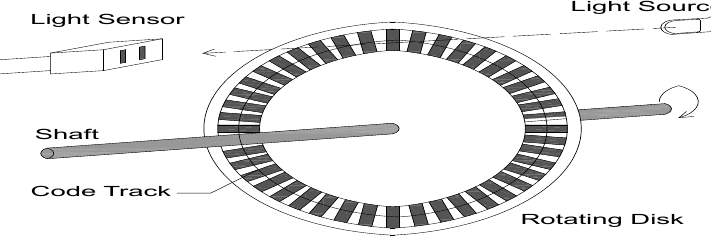
Figure 4. Schematic of a typical optical encoder (Authors’ sketch).